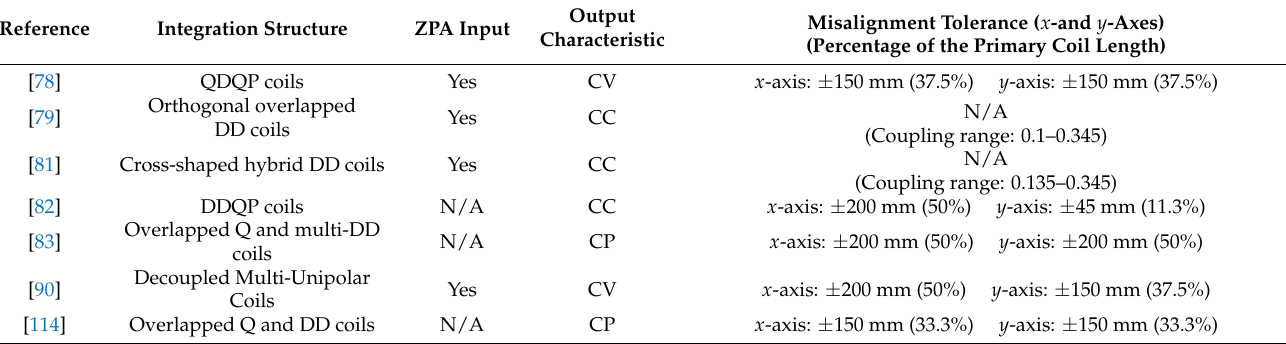
Table 6. Summary of the double-sided integration